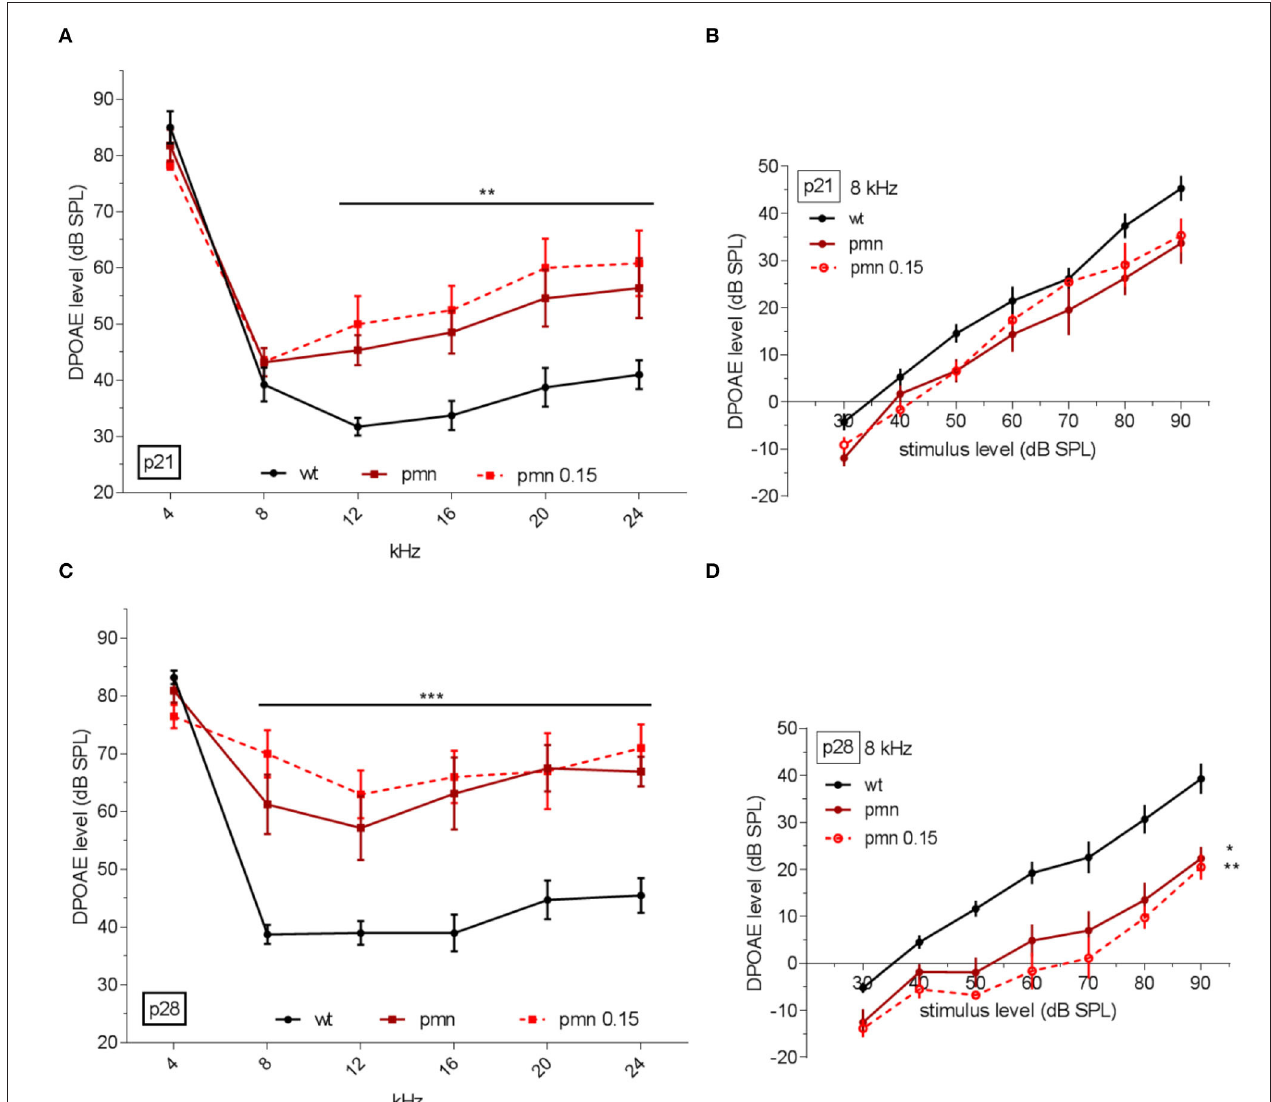
FIGURE 3 | DPOAE analysis in dB SPL at recorded frequencies. (A) DPOAE recorded hearing threshold at p21. Treated and untreated PMN mice had a significant increase at 12, 16, 20, and 24kHz ( p < 0.01) compared to the control littermates. (B) A slope function at 8kHz showed no significantly different slope function between the three groups. (C) At p28, PMN mice had an increased threshold at 8, 12, 16, 20, and 24kHz ( p < 0.001). (D) At this age, the slope function showed a significant reduction in untreated PMN ( p < 0.05) and treated PMN mice ( p < 0.01) compared to the wildtype animals. DPOAE thresholds: Regular two-way ANOVA with multiple comparison tests and post hoc Tukey analysis. Slope function: Ordinary one-way ANOVA with multiple comparison tests and Holm-Sidak post hoc analysis. Significances: * p < 0.05, ** p < 0.01, *** p <